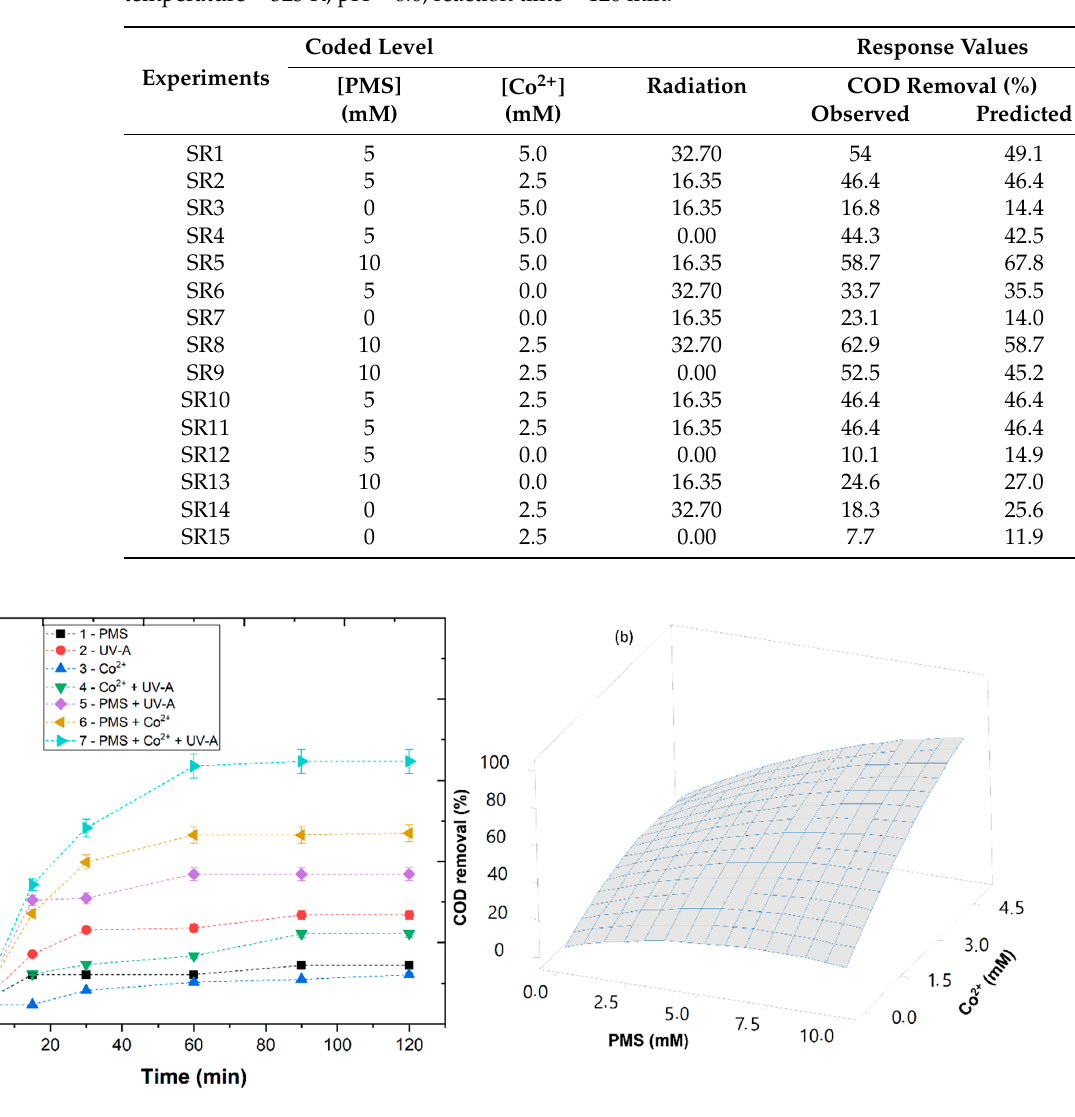
Figure 4. SR-AOP optimization: ( a ) experiments with different oxidation systems in the reduction in COD from WW1, ( b ) response surface methodology. Operational conditions: COD = 616 mg O 2 /L, pH = 6.0, [PMS] = 5 mM, [Co 2+ ] = 2.5 mM, temperature = 323 K, radiation UV-A 32.7 W m − 2 , reaction time = 120